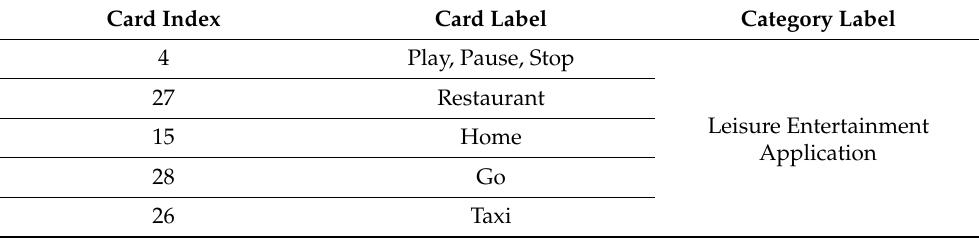
Table 8. Card sort